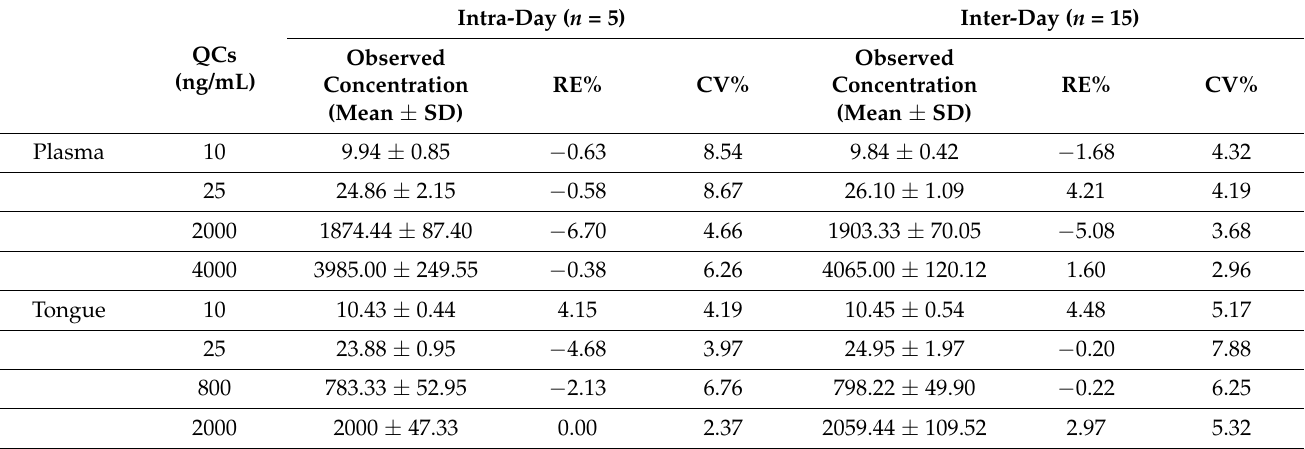
Table 1. Intra-day and inter-day accuracy and precision of OXP in rat plasma and tongue